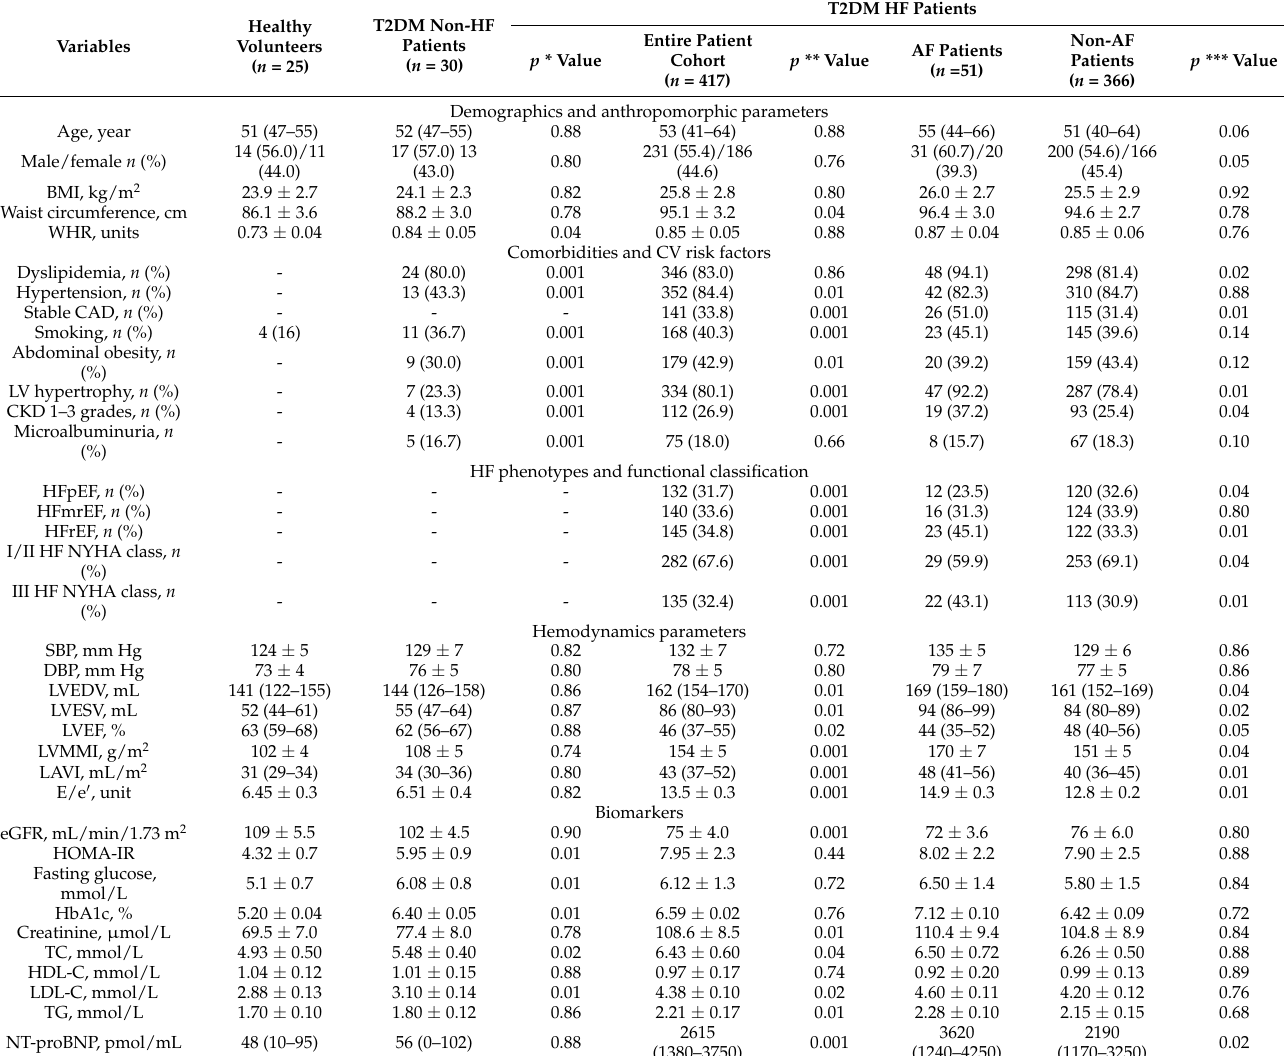
Table 1. Baseline general characteristics of eligible T2DM patients compared with healthy volunteers and T2DM non-HF